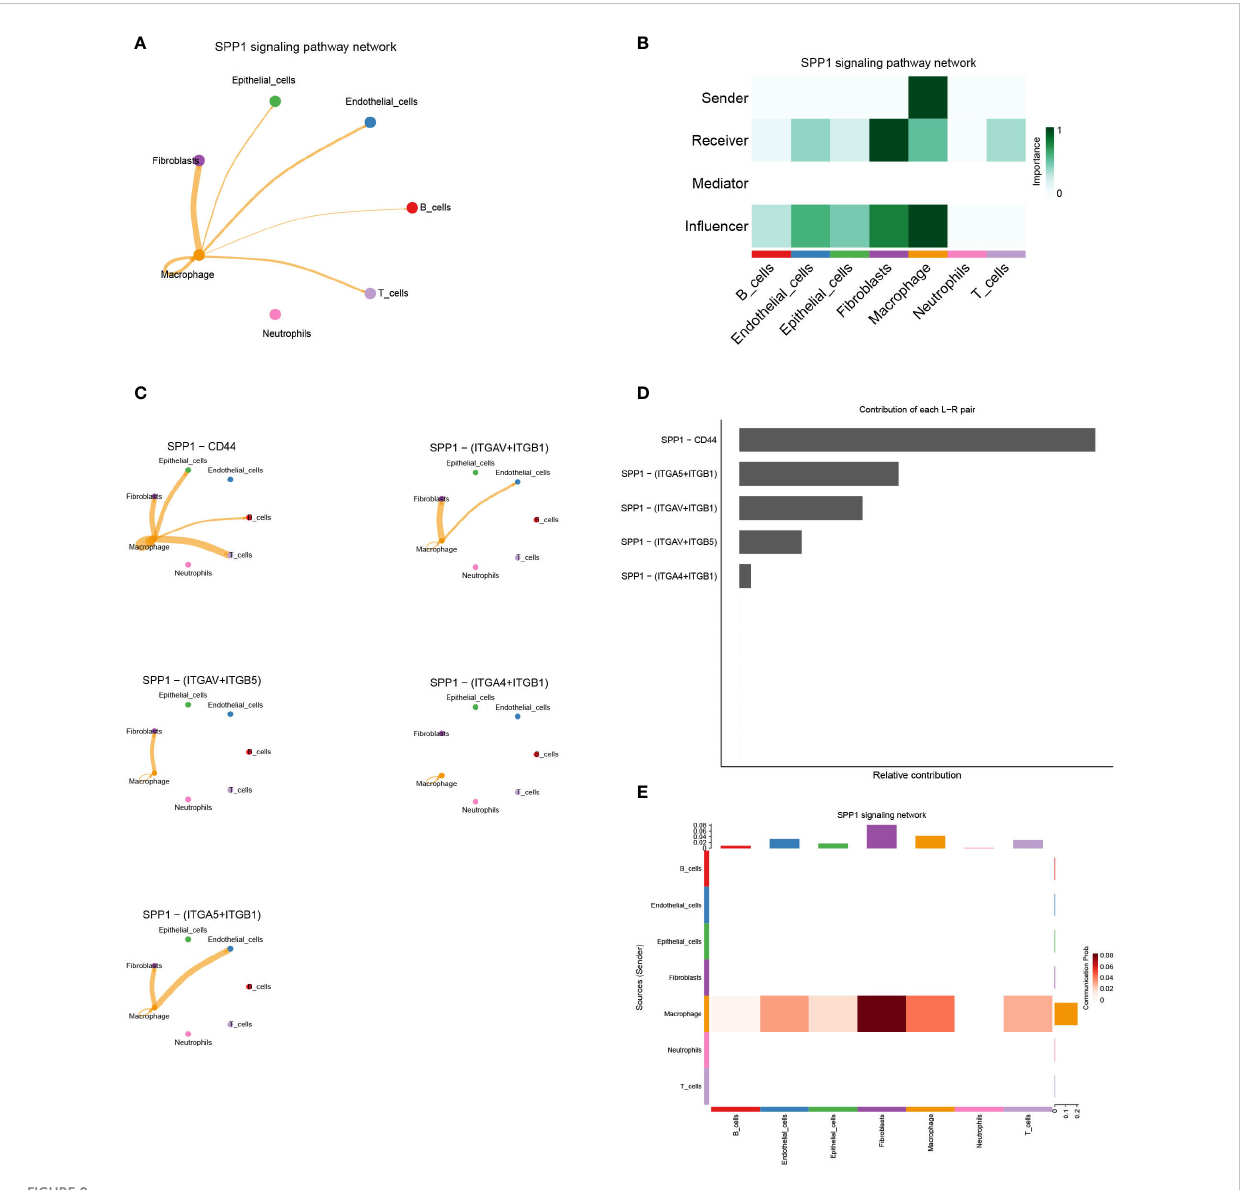
FIGURE 9 (A) Cell – Cell communications in SPP1 signaling pathway. (B) The role of each cell type in intercellular communication exchange. (C) Five types of ligand-receptor pairs in the SPP1 signaling pathway. (D) Contribution of each ligand − receptor pair in the SPP1 signaling pathway. (E) The intercellular communication probability between different cell types in the SPP1 signaling